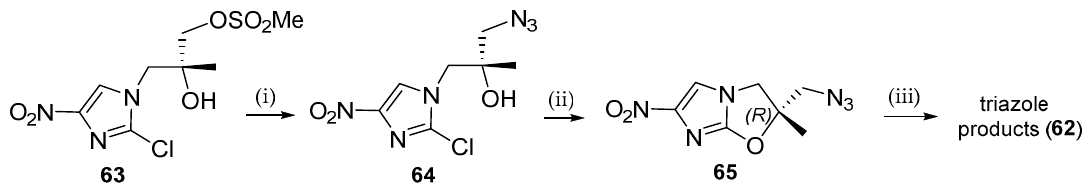
Figure 15. Truncated delamanid triazole analogues ( 62 ).